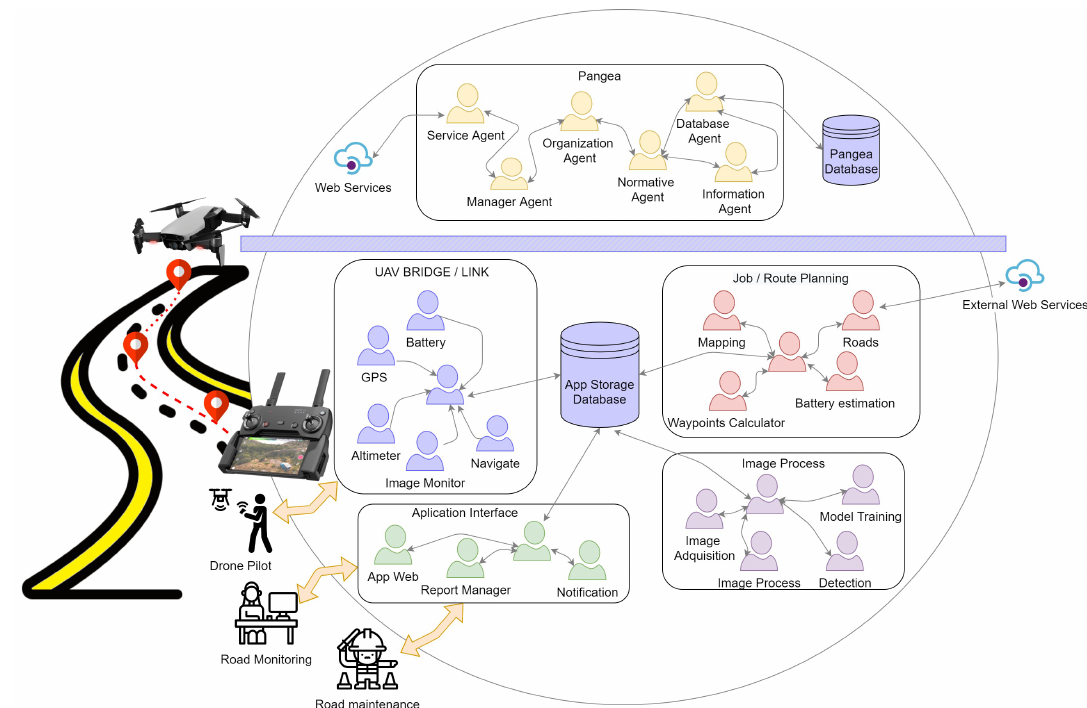
Figure 1. Proposed architecture using multi-agent system (MAS) PANGEA.